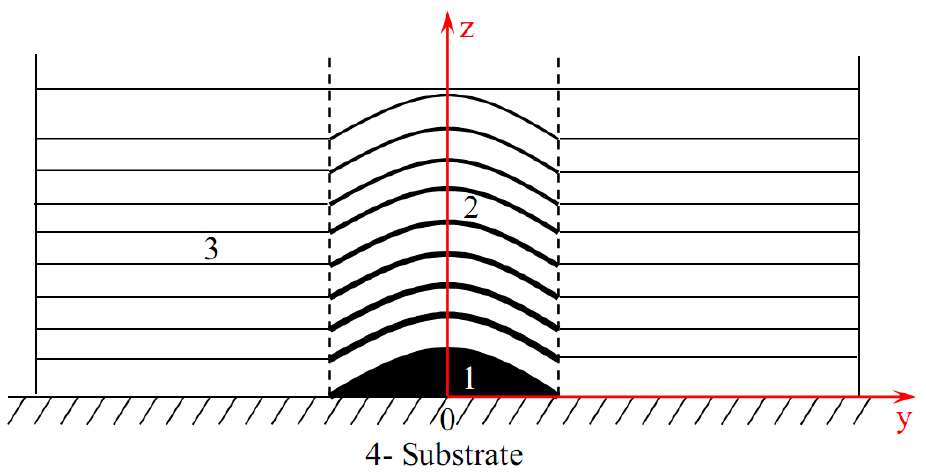
Figure 8. Cross section of a droplet in a nanolayer environment.